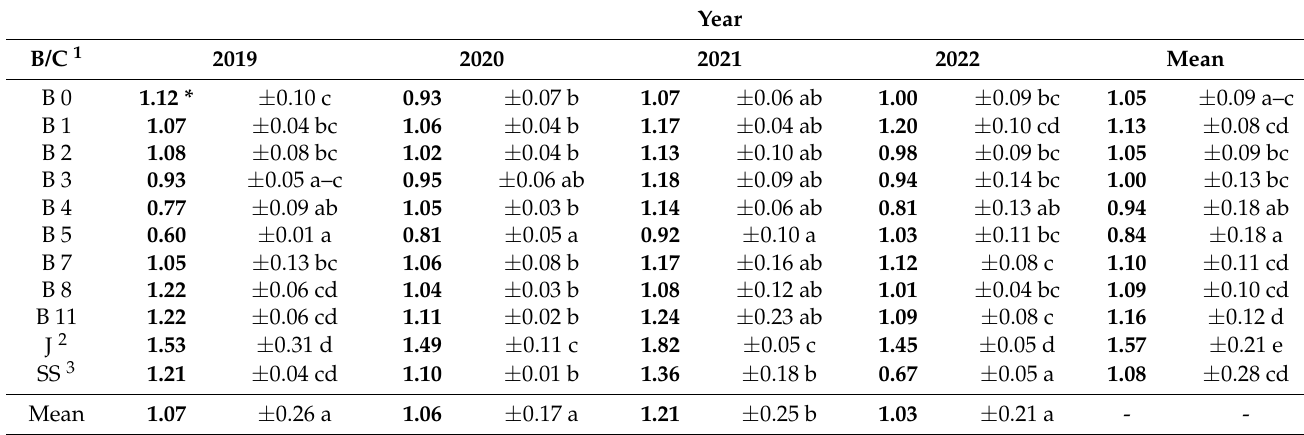
Table 7. Mean fruit weight (g) of Elaeagnus multiflora biotypes and